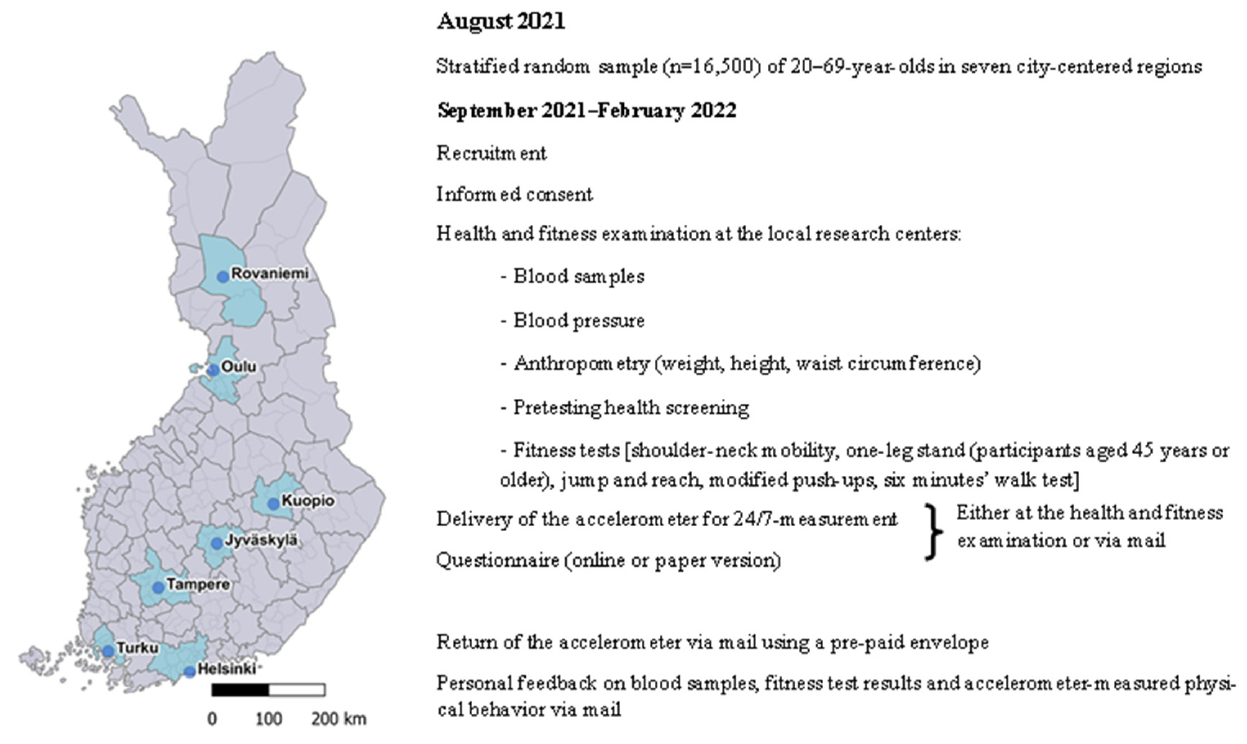
Figure 1. The seven study regions and flowchart of the data collection. Municipality and city region area boundaries, Statistics Finland, Tilastointialueet 2017. The material was downloaded from the Statistics Finland’s interface service on 11 November 2021 with the license CC BY 4.0.